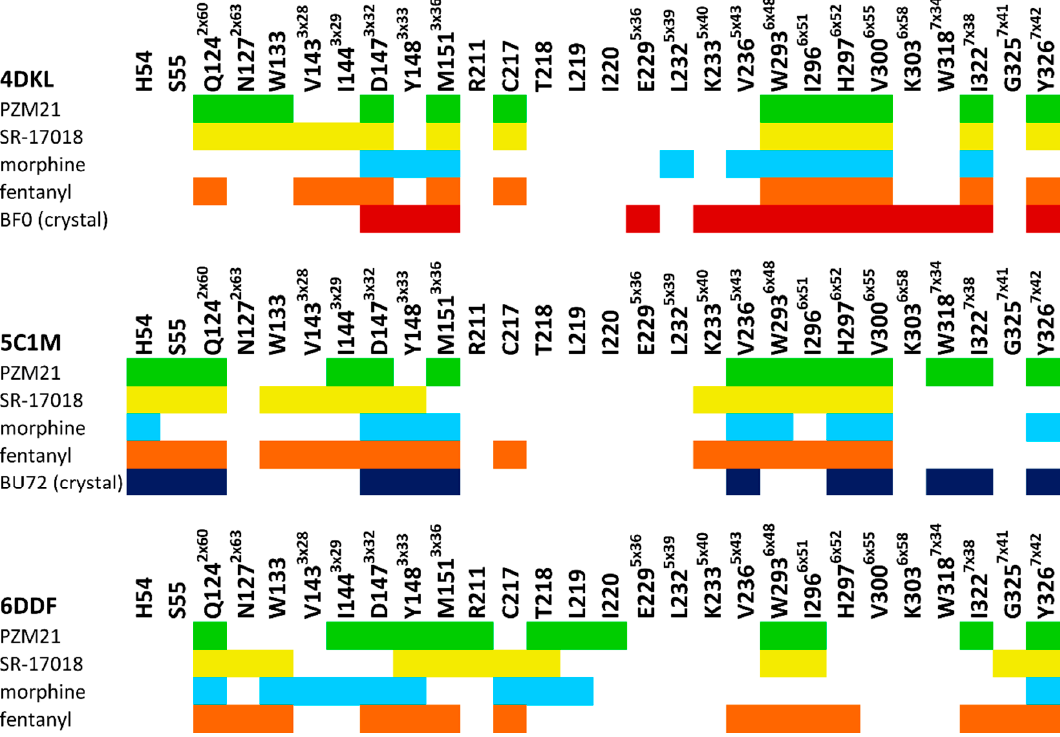
Figure 4. Ligand–protein contacts occurring within complexes obtained in docking to various µ opioid receptor crystal structures. For comparison, interactions of co-crystallized BF0 and BU72 with respective crystal structures are included.